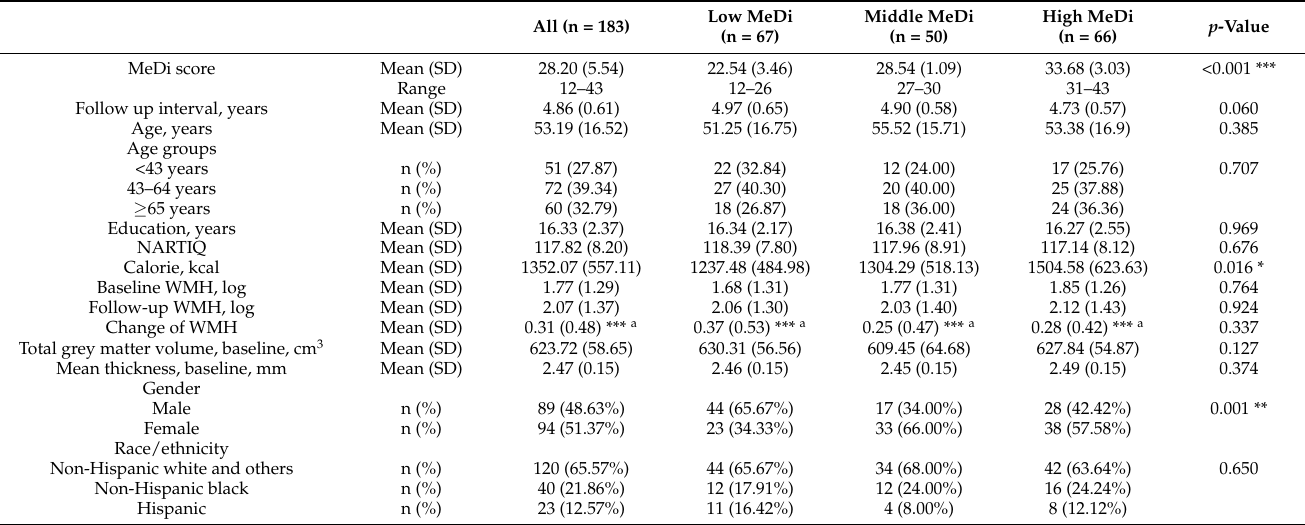
Table 1. Summary of characteristics (n =